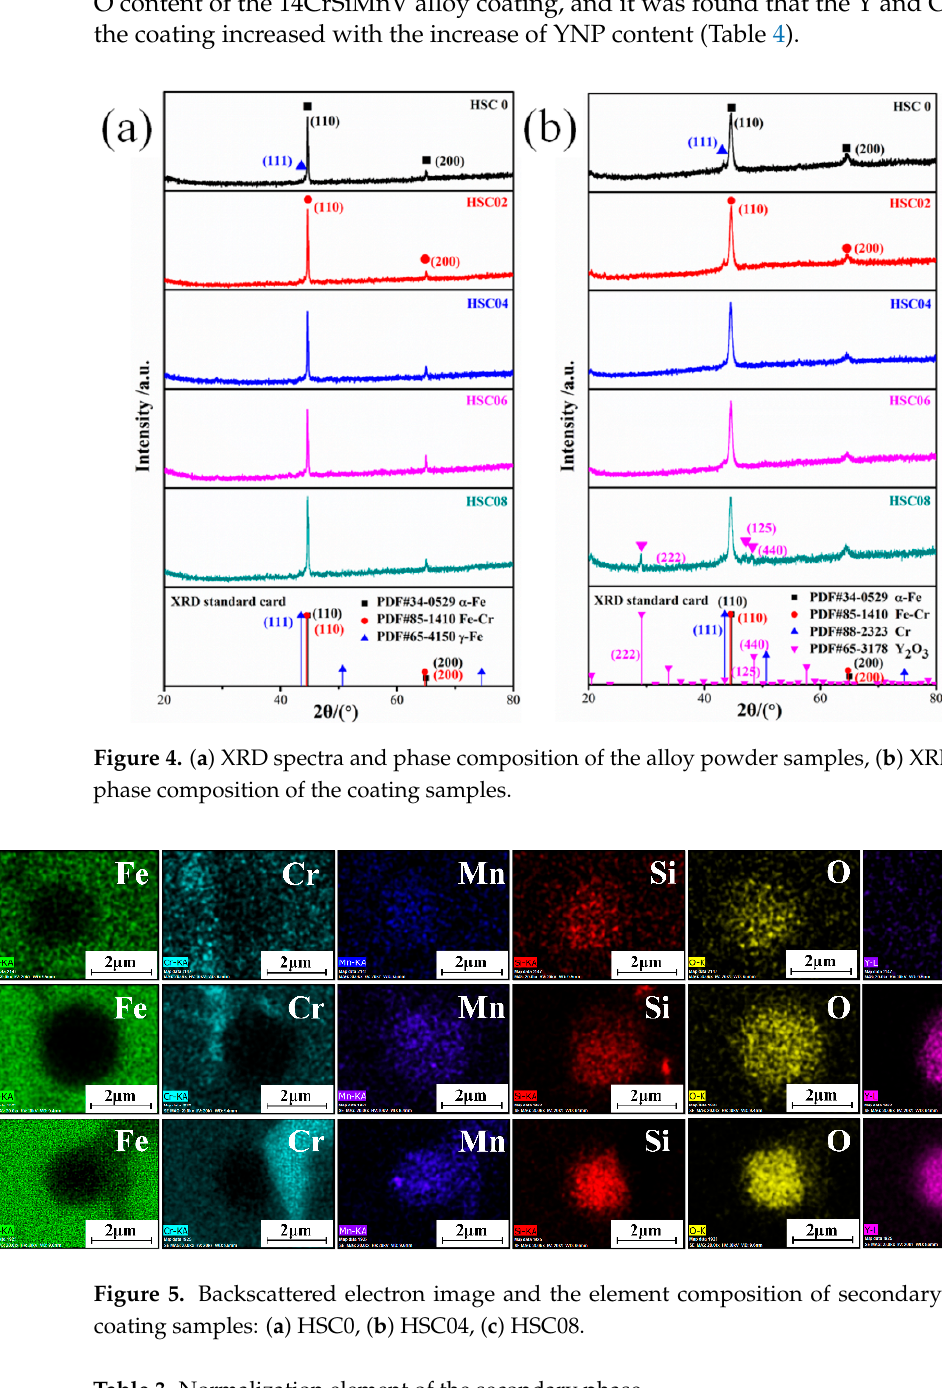
Table 3. Normalization element of the secondary